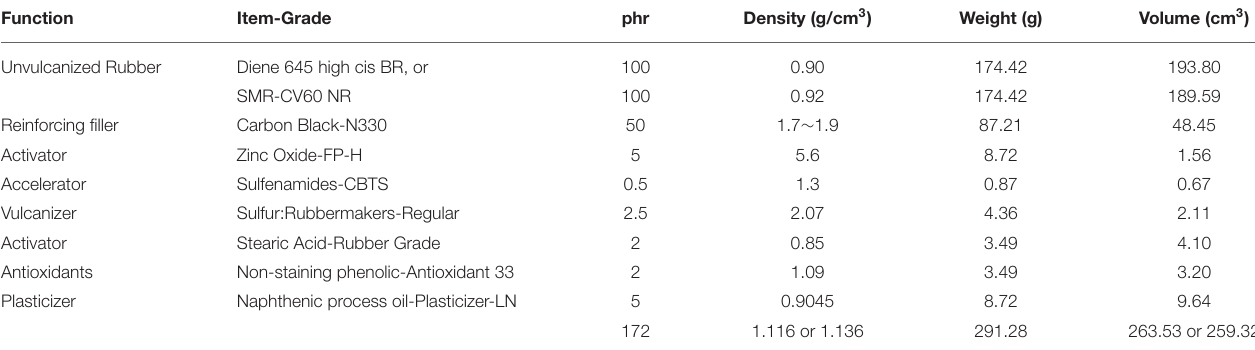
TABLE 1 | Compound recipes.